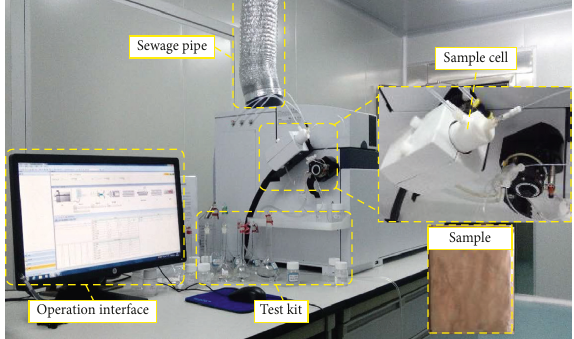
Figure 3: Inductively coupled plasma mass spectrometer (ICP-MS).